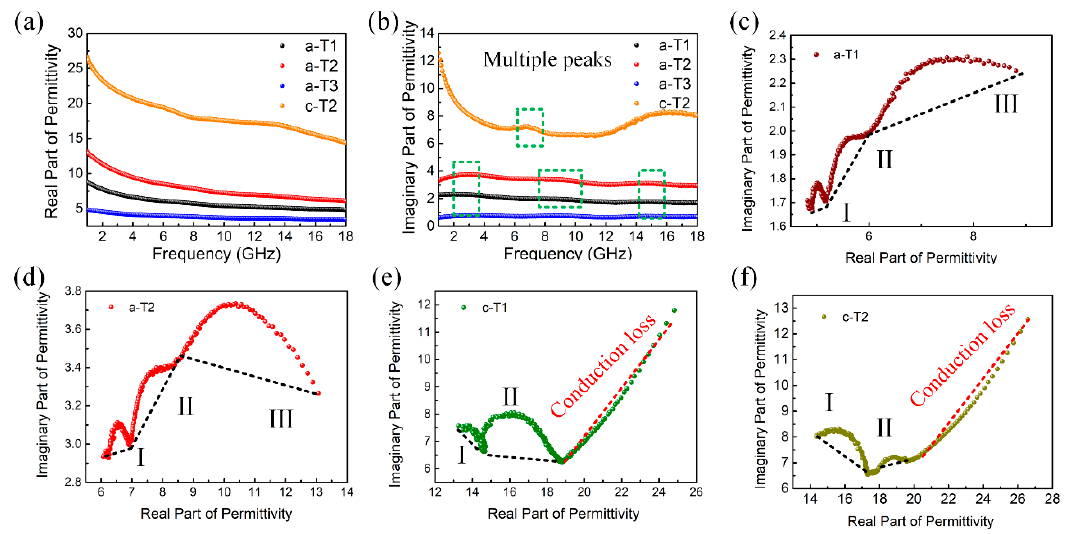
Figure 5. ( a ) Real permittivity, ( b ) imaginary permittivity of a-T1, a-T2, a-T3 and c-T2 at 2-18 GHz; Cole-Cole plots of ( c ) a-T1, ( d ) a-T2, ( e ) c-T1 and ( f ) c-T2.